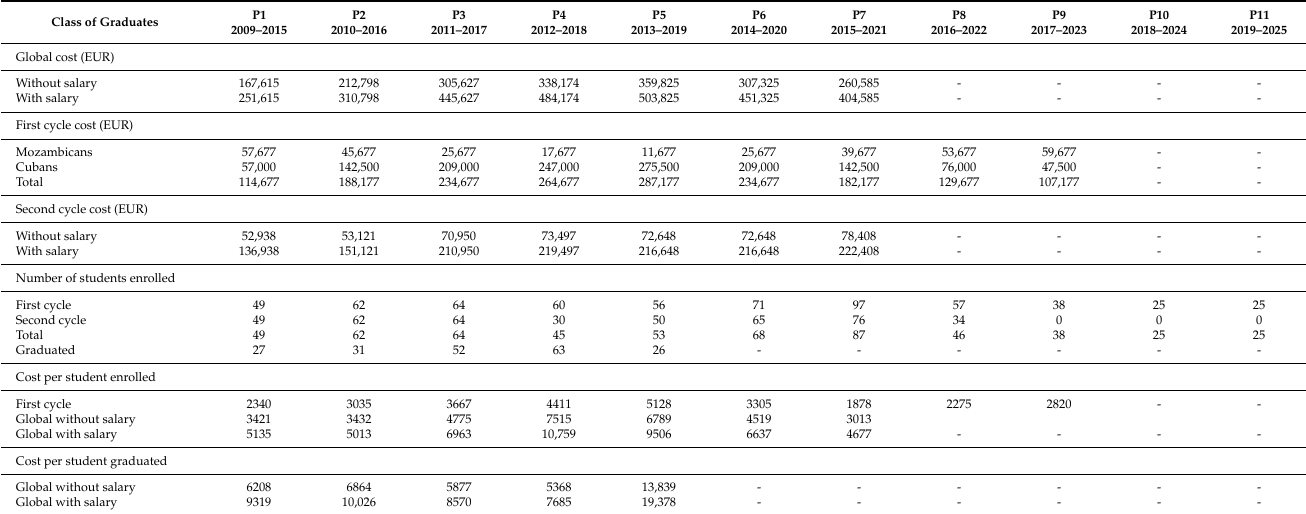
Table 1. Cost (EUR, 2019 prices) and number of students per class of graduates